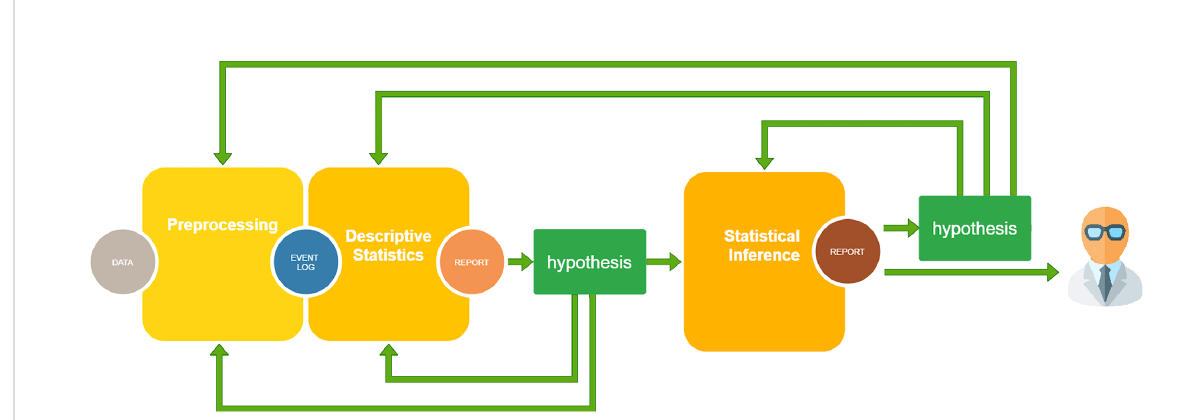
FIGURE 1 The computational pipeline exploited for the analysis: (i) Preprocessing: data quality is assessed, data with excessive detail are grouped, missing data are removed or imputed and data are shaped in form of an Event Log, the usual input format for Process Mining analysis; (ii) Descriptive Statistics: several indicators are computed on the cohort at hand to suggest some possible hypotheses; (iii) Statistical Inference: statistical signi fi cance tests, future event risk predictions, and rationalization of results by domain experts. Here, other hypotheses can be added and the analysis can be enriched, looping back to one of the previous